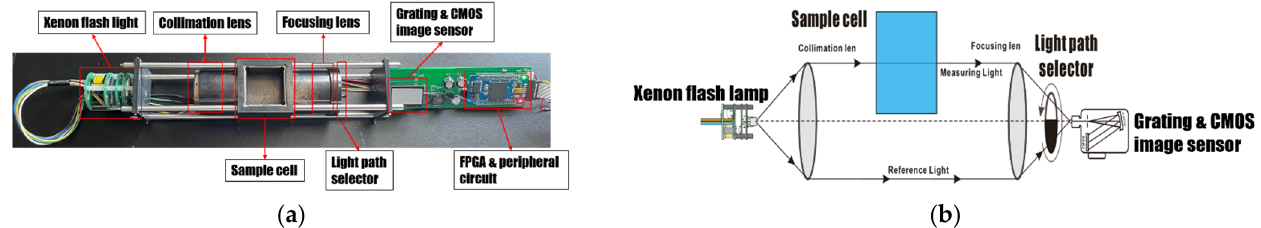
Figure 1. ( a ) Physical structure of the implemented spectrophotometer platform. ( b ) Schematic of the fused double-beam structure.